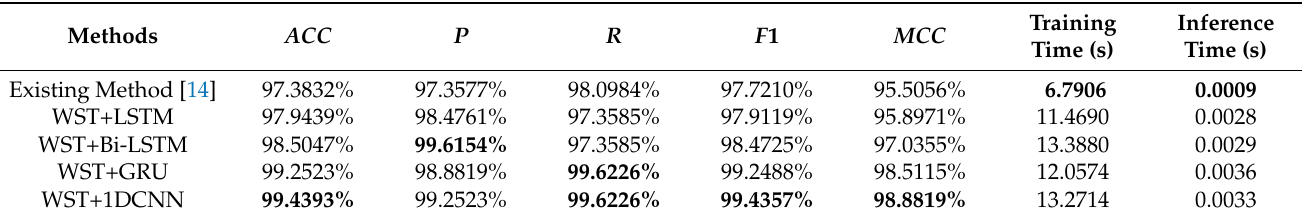
Table 2. Experimental results of electrical signal classification algorithm based on wavelet scattering transformation feature.